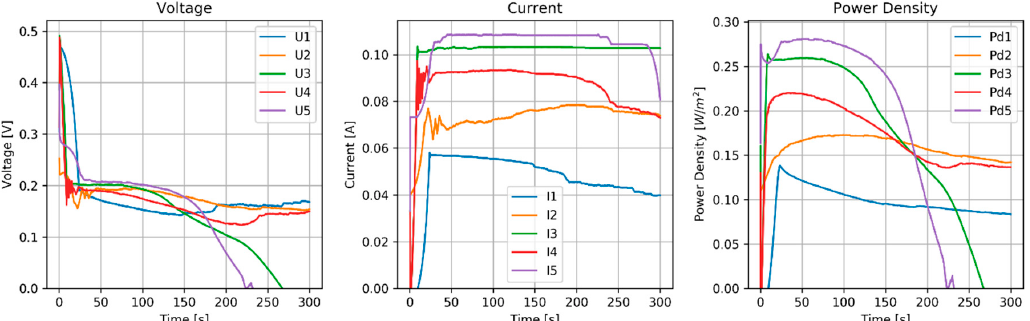
Figure 4. Results of maximum power point tracking (MPPT) test of the RED stack equipped with normal CEMs (CMX) and pseudo AEMs (Ag/AgCl).